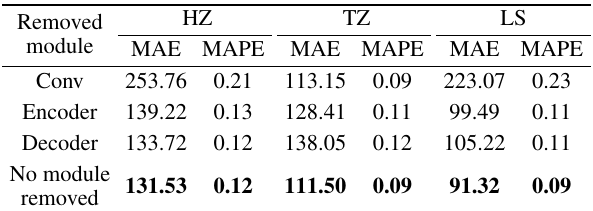
Fig. 6 Performance of different training